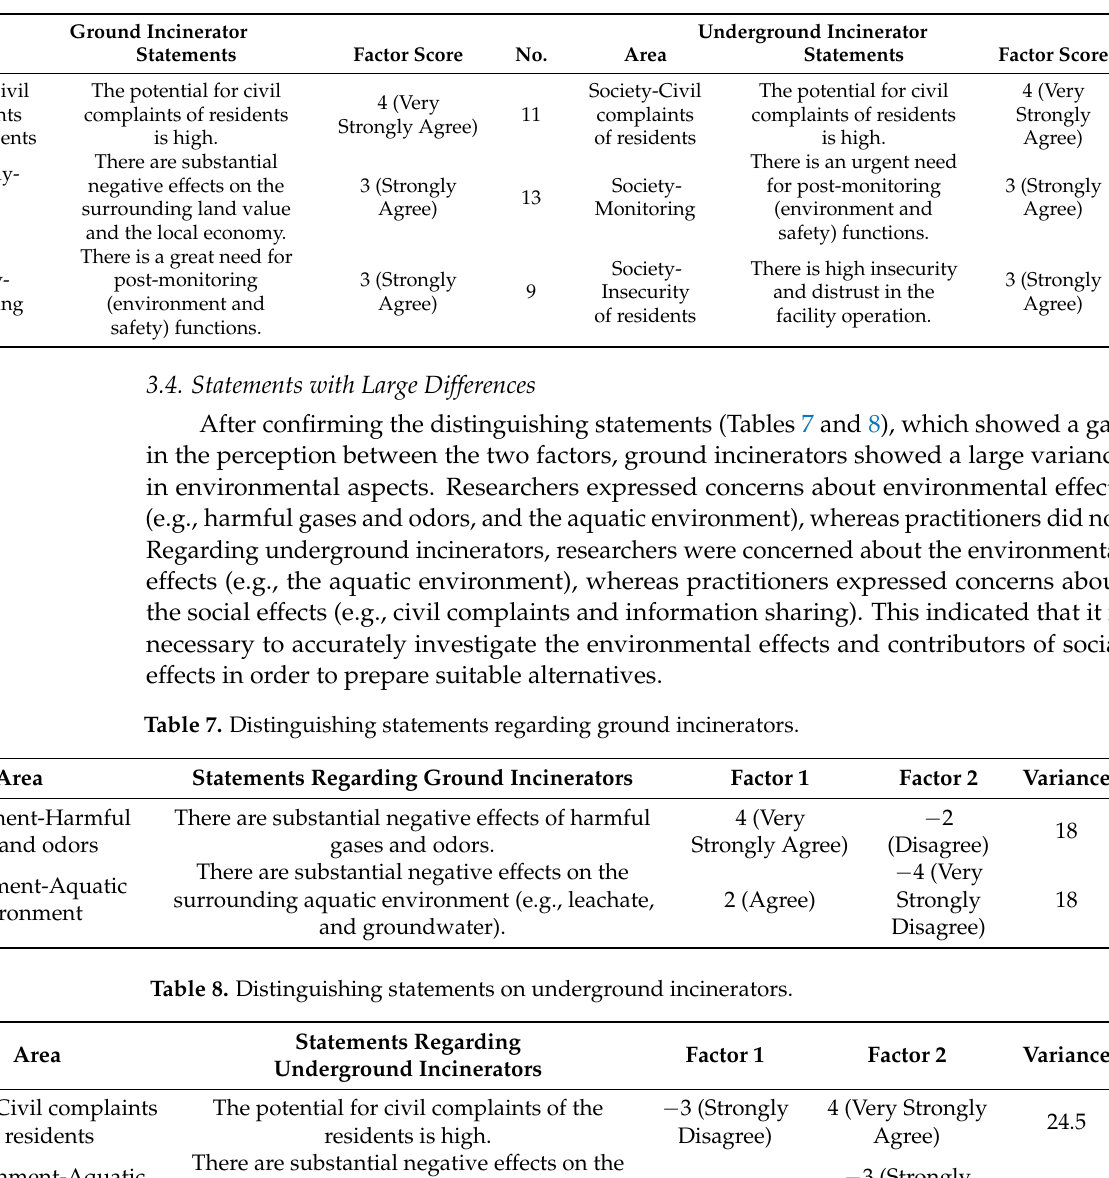
Table 6. Main statements of Factor 2 (Industry).